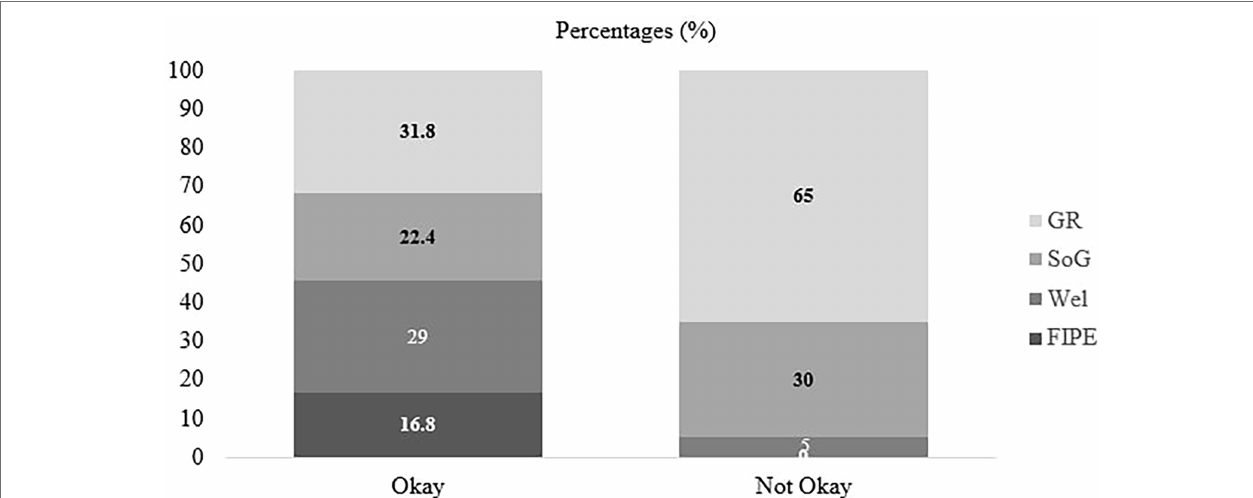
FIGURE 5 | Percentages of participants reasoning of perceived group evaluation of challenger by their group evaluation judgments of challenger (categorized as okay versus not okay). FIPE, Fairness and Individual Rights and Prejudice and Equality; Wel, Welfare; SoG, Social and Group Norms; and GR, Group Dynamics and Functions and Repercussions and Representation Management. Numbers represent the percentages of participants within “okay” and “not okay”